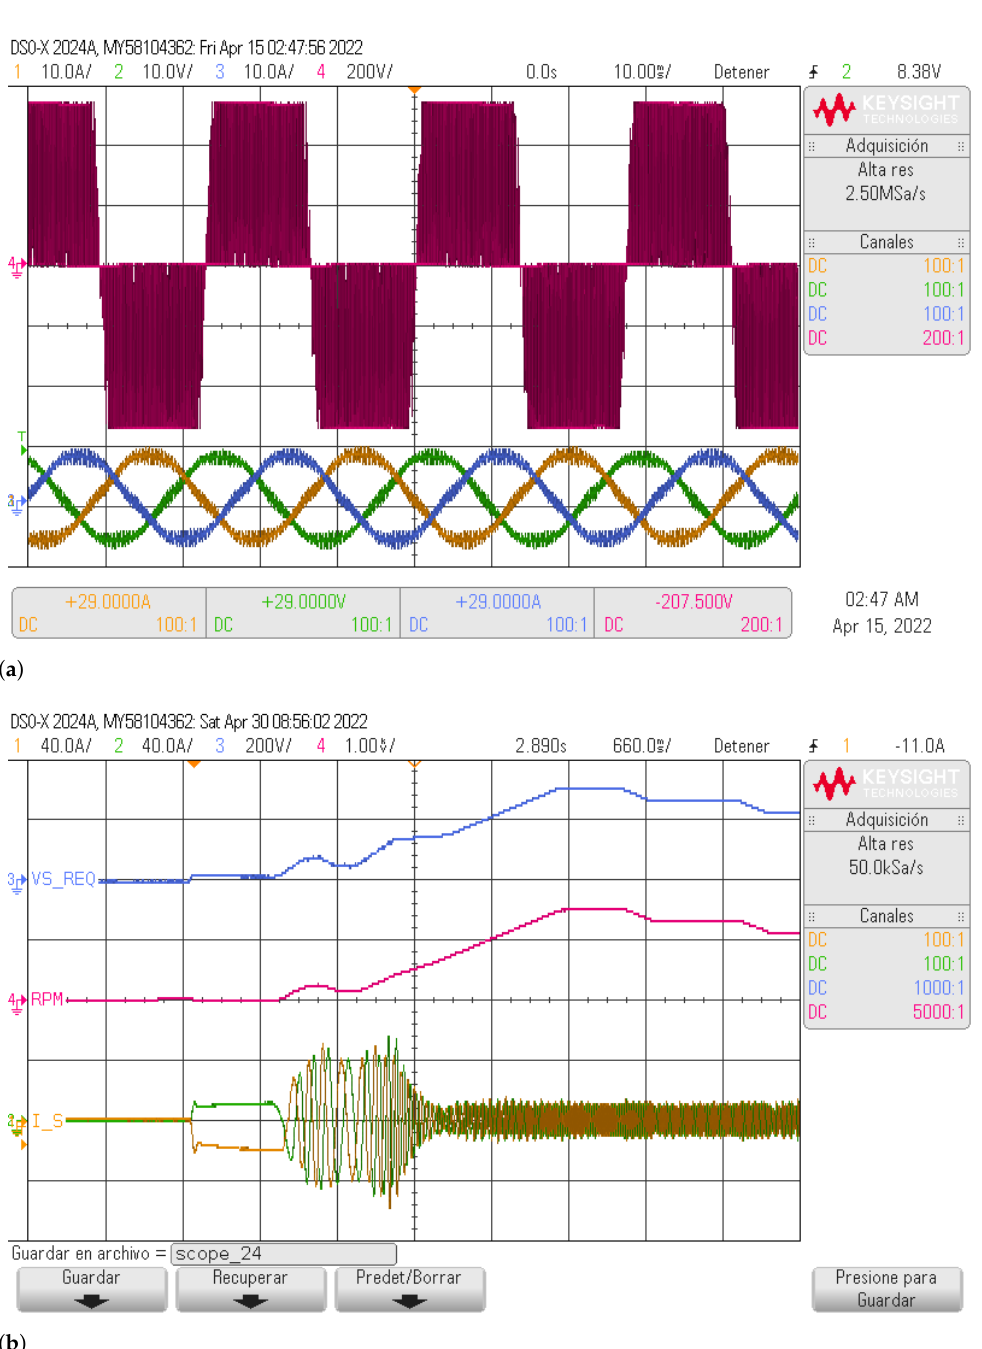
Figure 7. Previous HST-SCS [17] experimental results. ( a ) Oscilloscope waveform of a-b line voltage and phase currents, during 100 ms around 4.2 s. ( b ) Oscilloscope waveforms of V ∗ s , ω r , and phase currents i a and i b